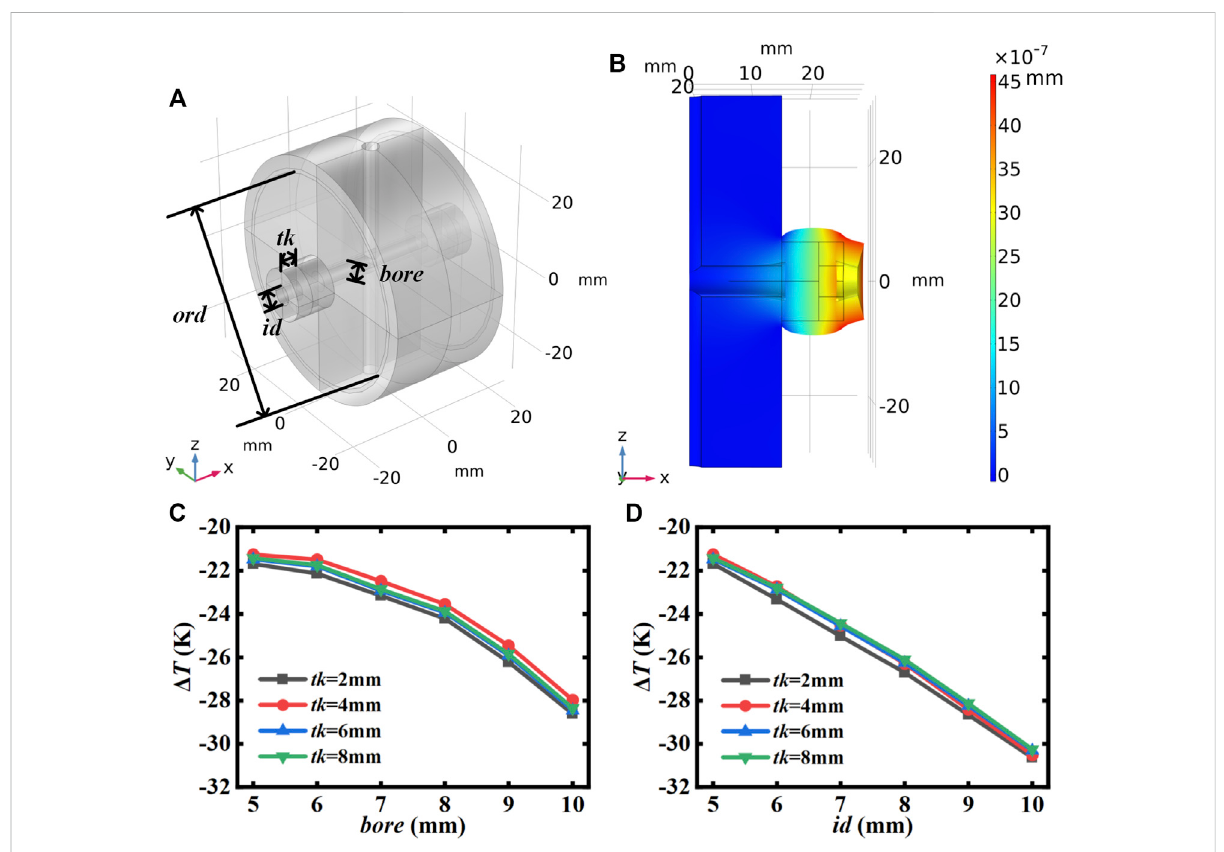
FIGURE 1 (A) 3D model of the “ sandwich ” structure cavity. (B) FEA simulations of the “ sandwich ” structure cavity deformation after a 1-K